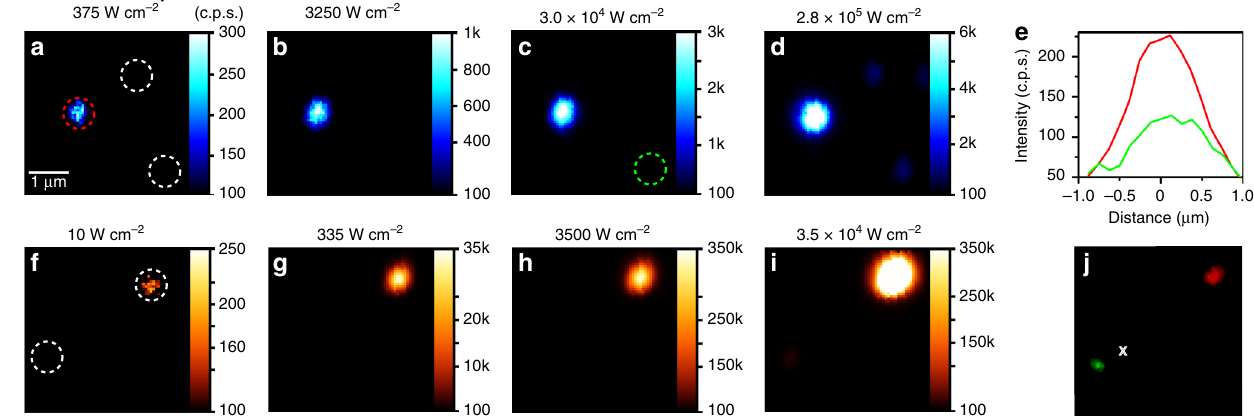
Fig. 4 Multiphoton imaging at low irradiance. a – d Images of single core/shell 8-nm NaEr 0.2 Yb 0.8 F 4 aUCNPs (red dashed circle) and 8-nm NaYF 4 : 20% Yb 3 + , 20% Er 3 + UCNPs (white dashed circles), with emission intensity scale in c.p.s. next to each image. Scale bar is 1 μ m. e Linecuts of single NaEr 0.2 Yb 0.8 F 4 core/shell aUCNP at 375 W cm − 2 (red circle) and NaYF 4 : 20% Yb 3 + , 20% Er 3 + UCNP at 30,000 W cm − 2 (green circle). f – i Images in 0.5- μ m polystyrene beads loaded with ensembles of UCNPs (compositions as in a – d ). j Bright fi eld image of the two beads in f – i , with 980-nm laser focused at the